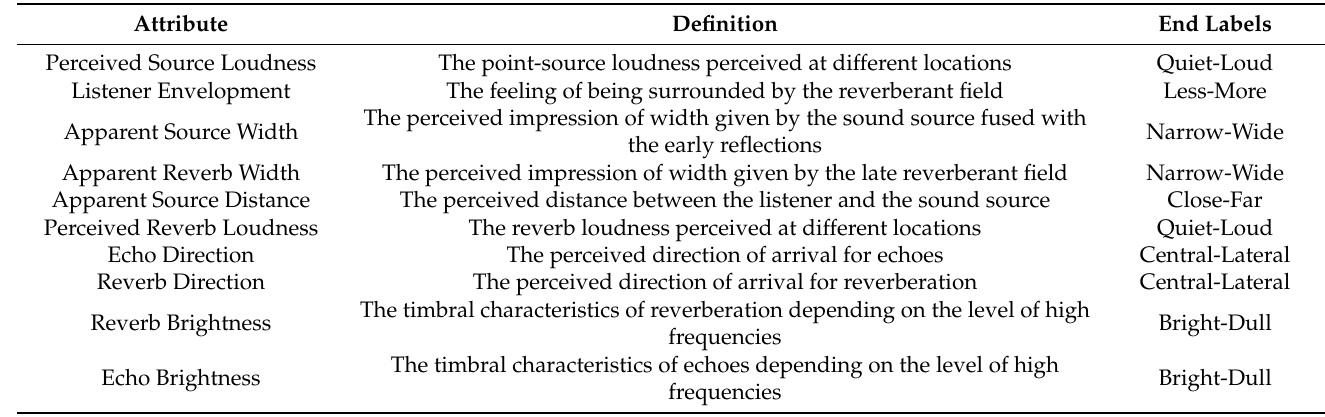
Table 5. Salient attributes with their definitions and